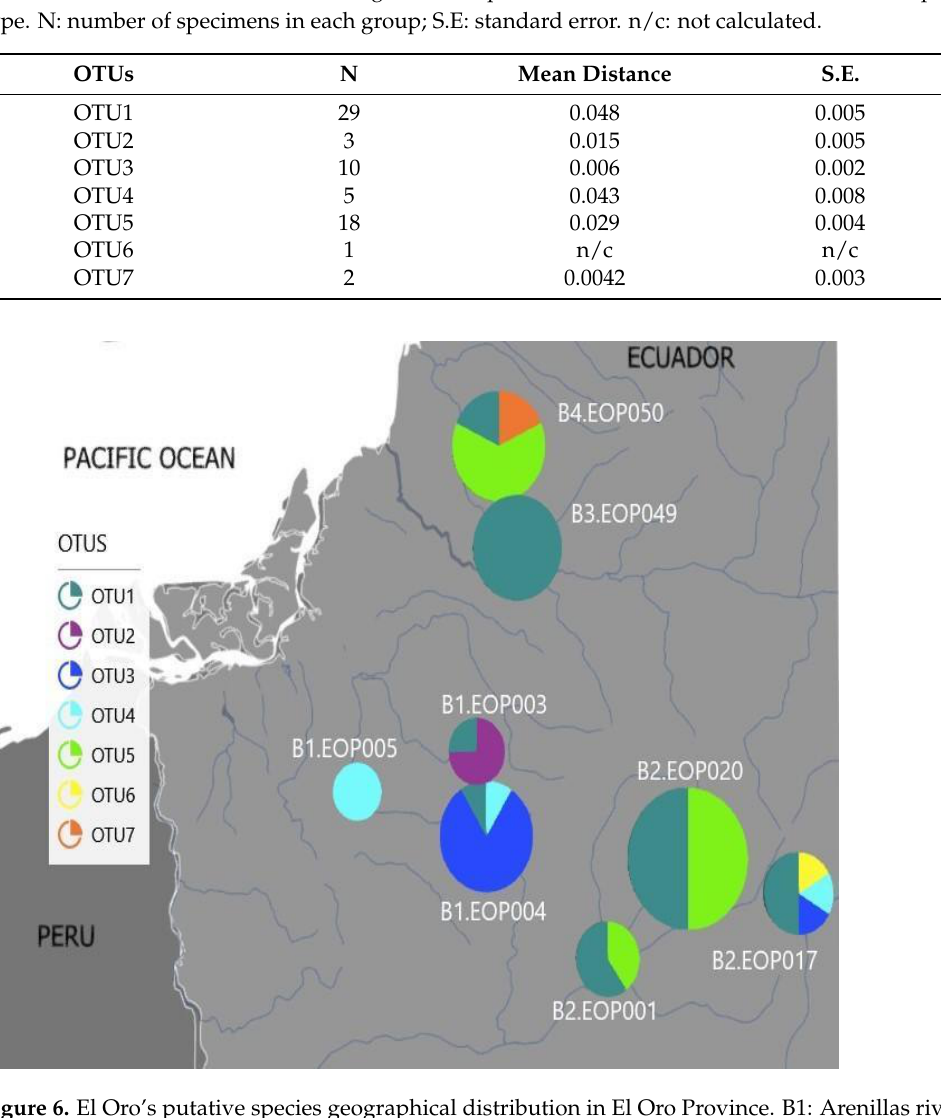
Figure 6. El Oro´s putative species geographical distribution in El Oro Province. B1: Arenillas river basin, B2: Puyango river basin, B3: Jubones river basin, and B4: Siete River river basin.